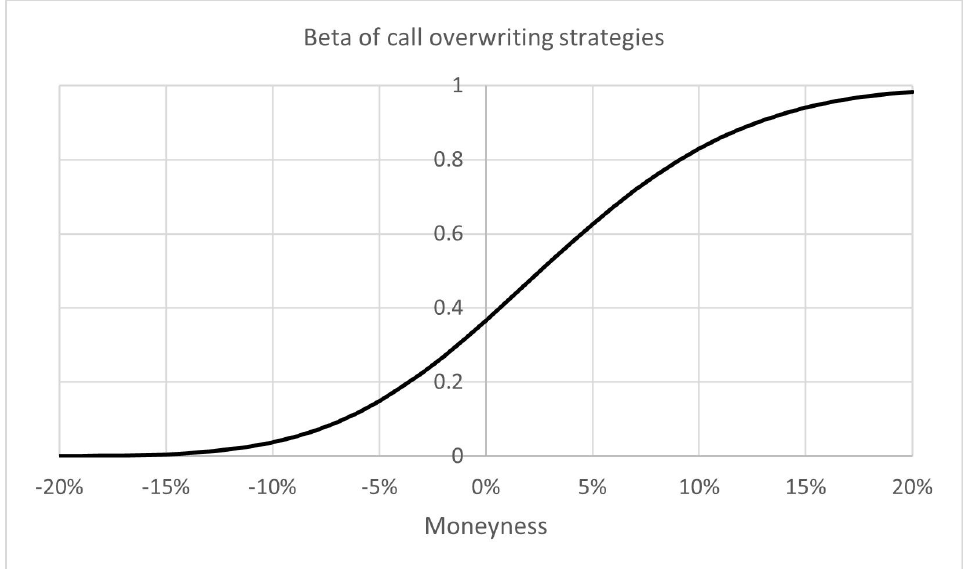
Figure 7. The price sensitivity (beta) of an underlying asset with an overlaid call overwriting strategy for a range of strike prices in relation to price change of the underlying asset.